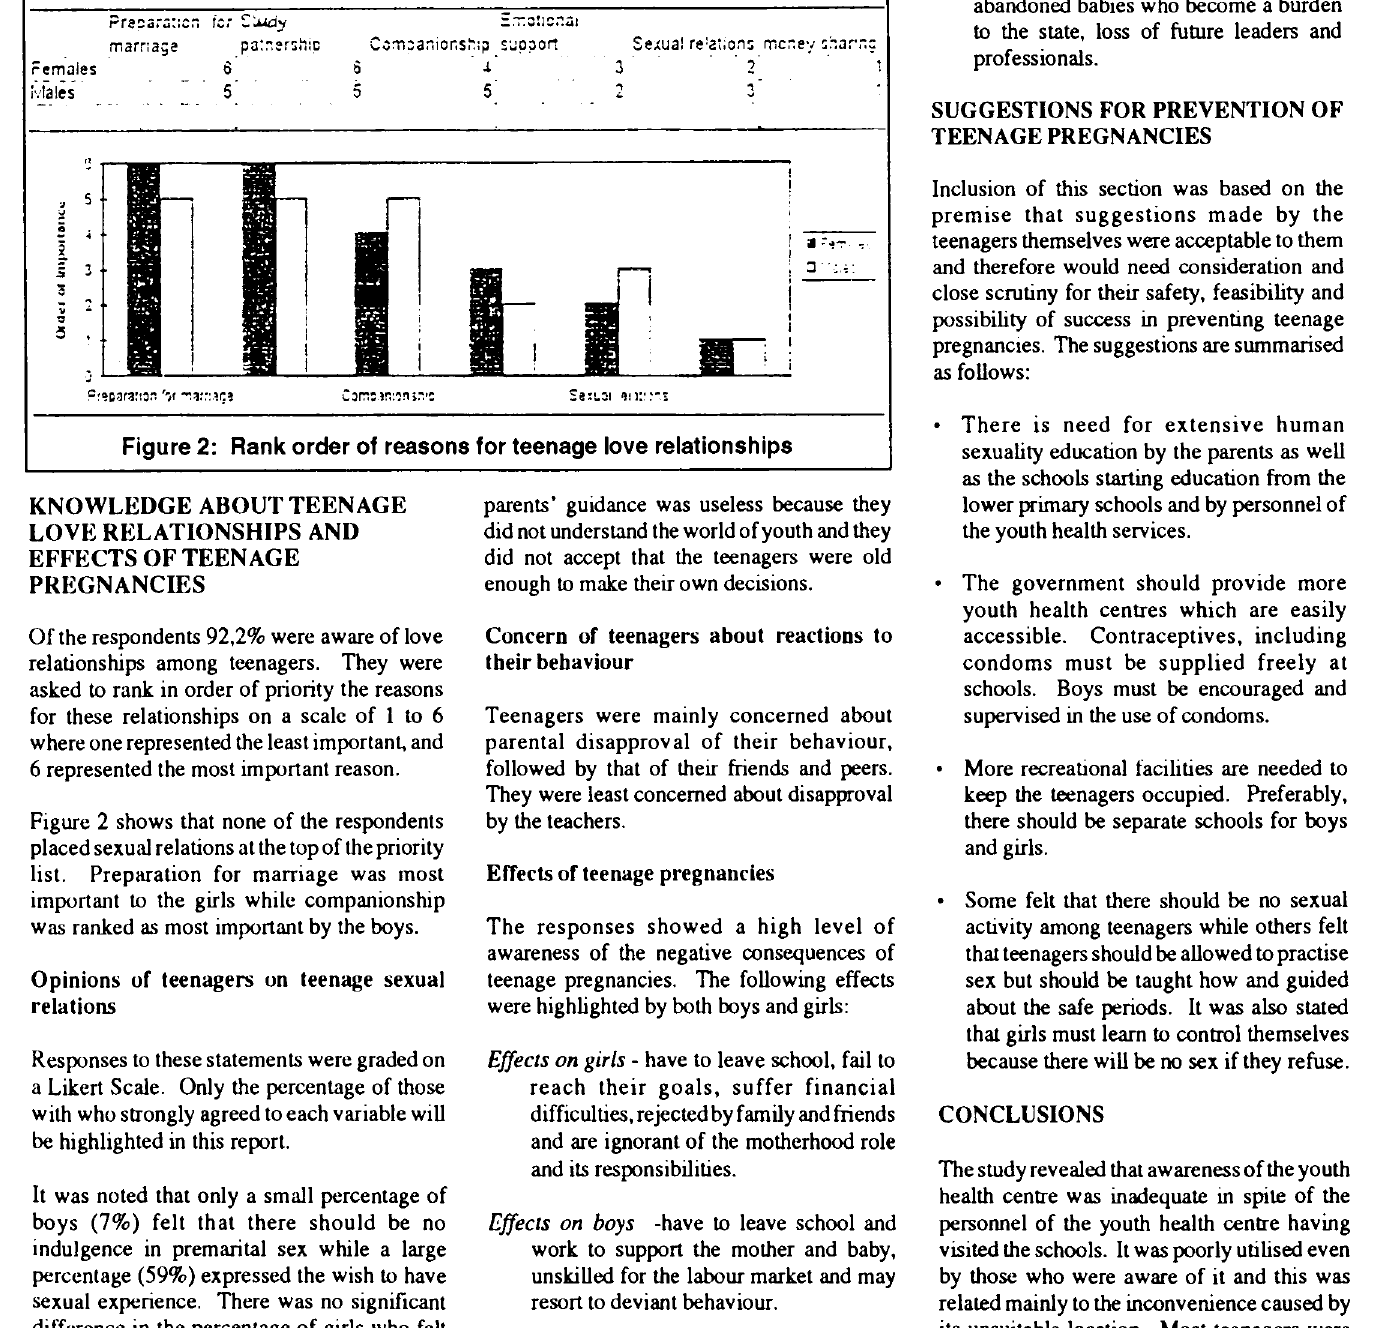
Table 3: Opinions on teenage sexual relations QuMtton Strongly Agree